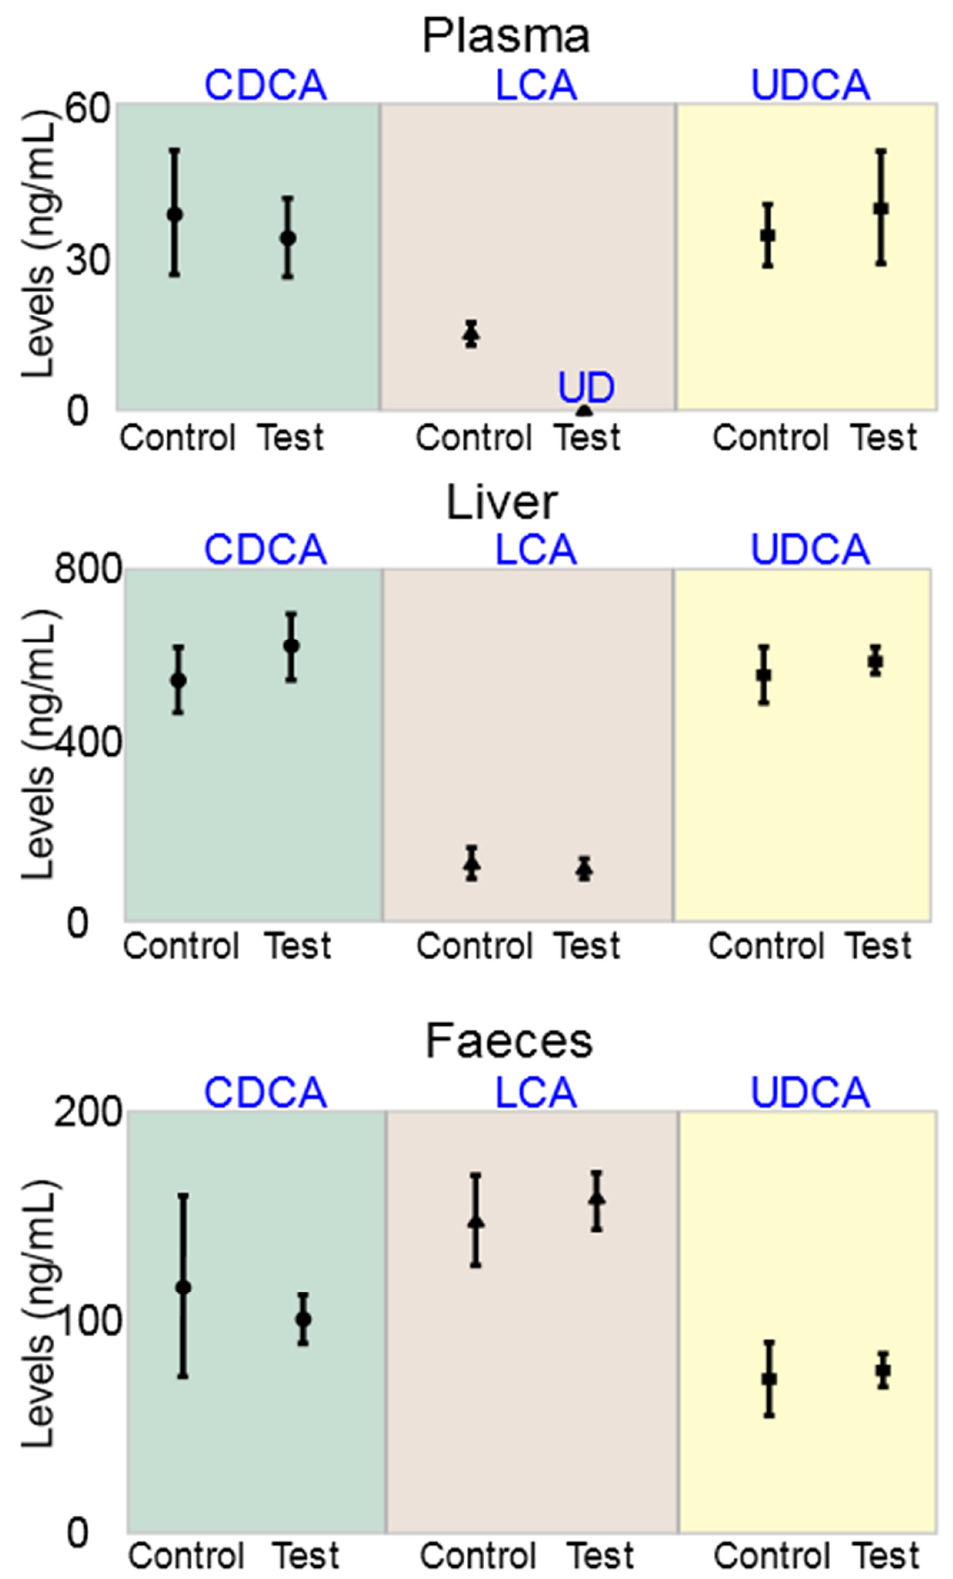
Figure 5. Bile acid concentrations in samples collected from the plasma, liver and faeces.